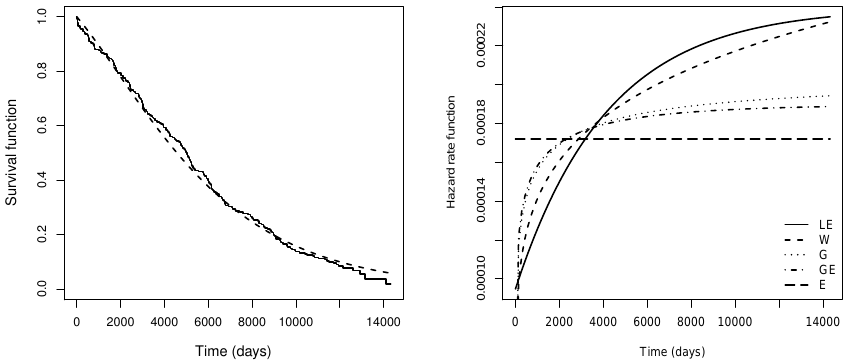
Figure 5. Left panel: Kaplan–Meier survival curve (solid line) and the fitted LE survival curve (dashed line) for the survival times of monoclonal gammopathy data. Right panel: Hazard rate function for the distributions fitted to the monoclonal gampathy